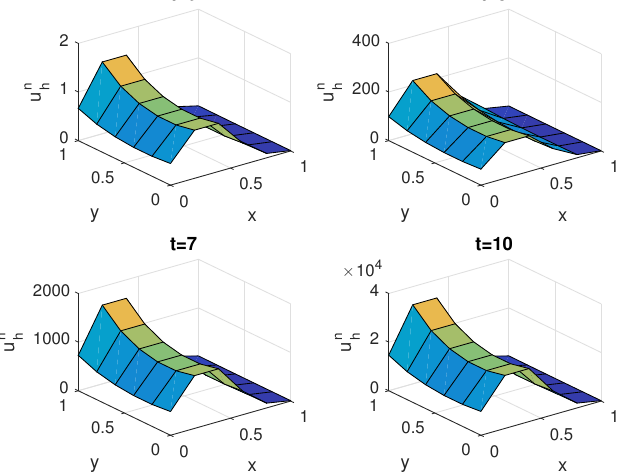
Figure 7. Numerical results of u n Experiment